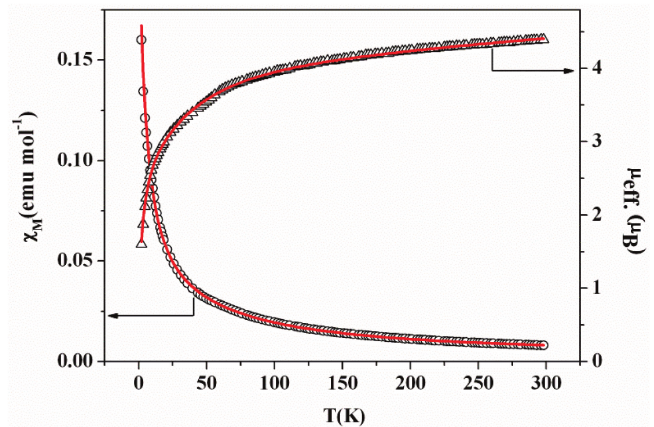
Figure 4. Temperature dependence of the molar susceptibility χ complex 1 ; solid lines are the product of a least-squares fit to the model indicated in the